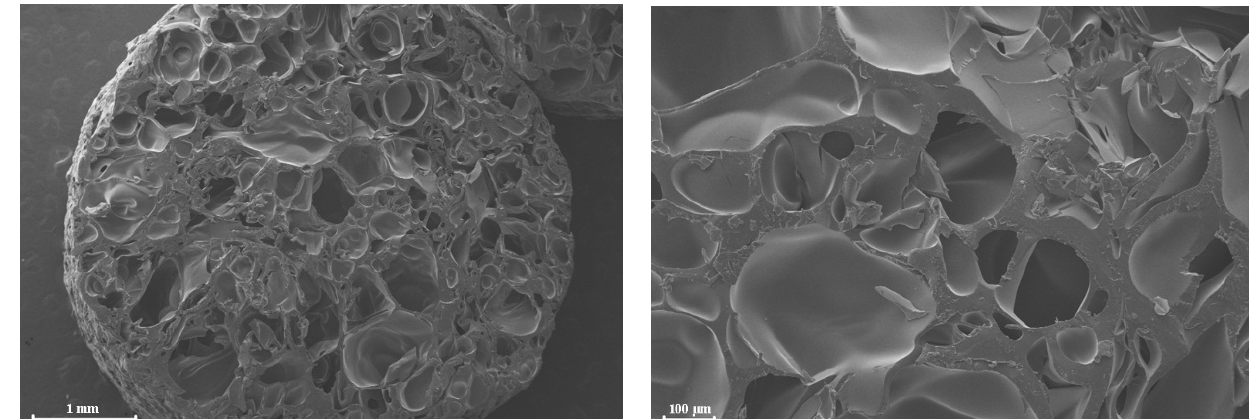
Figure 2. SEM images of PDLG 7502 porous samples at two different magnifications.